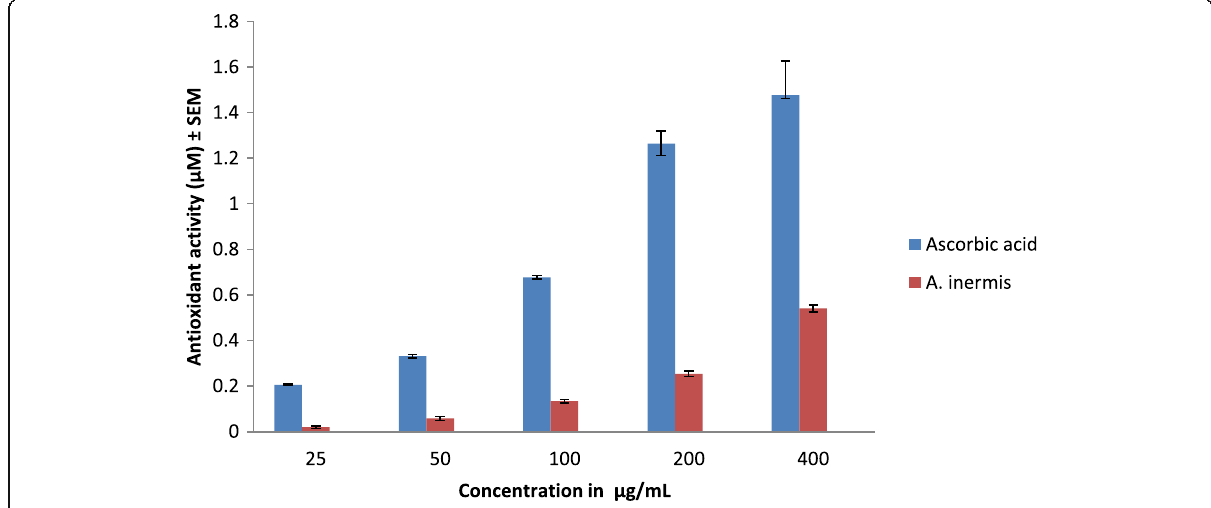
Fig. 1 FRAP Test showing A.inermis antioxidant activity (red bars) with Ascorbic acid (blue bars) as standard